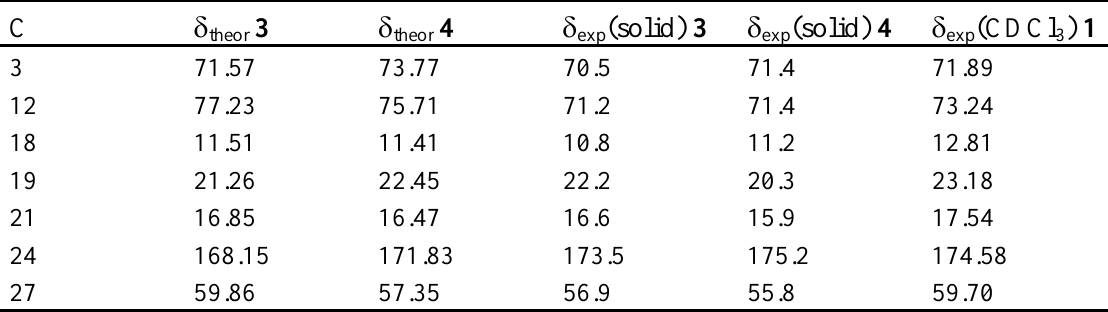
Table 5. Selected theoretical (B3LYP/6-311G*) and experimental 13 C NMR parameters calculated and measured for 3 and 4